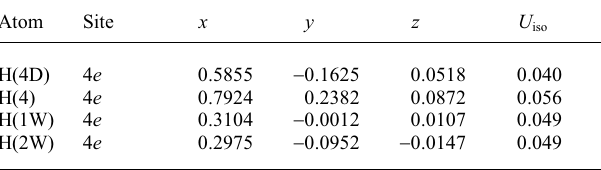
Table 2. Atomic coordinates and displacement parameters (in Å 2 )